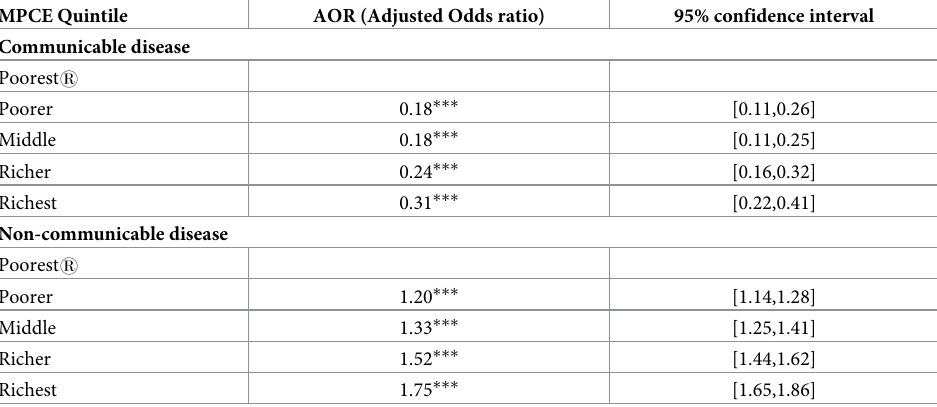
Table 4. Association of consumption expenditure with communicable and non-communicable